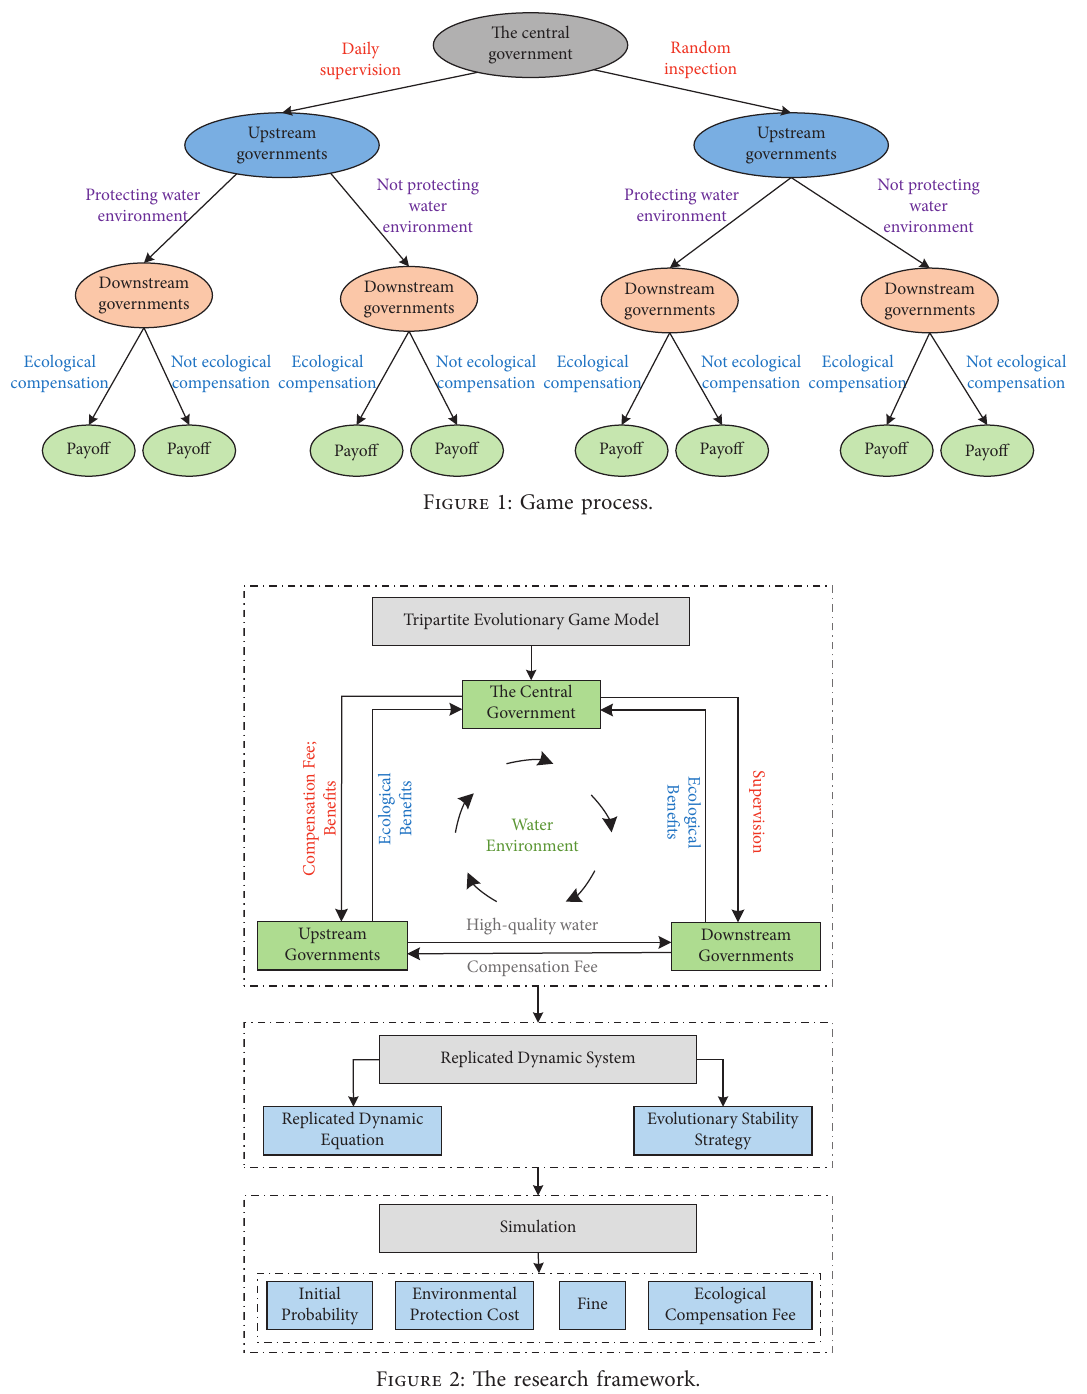
Figure 2: The research